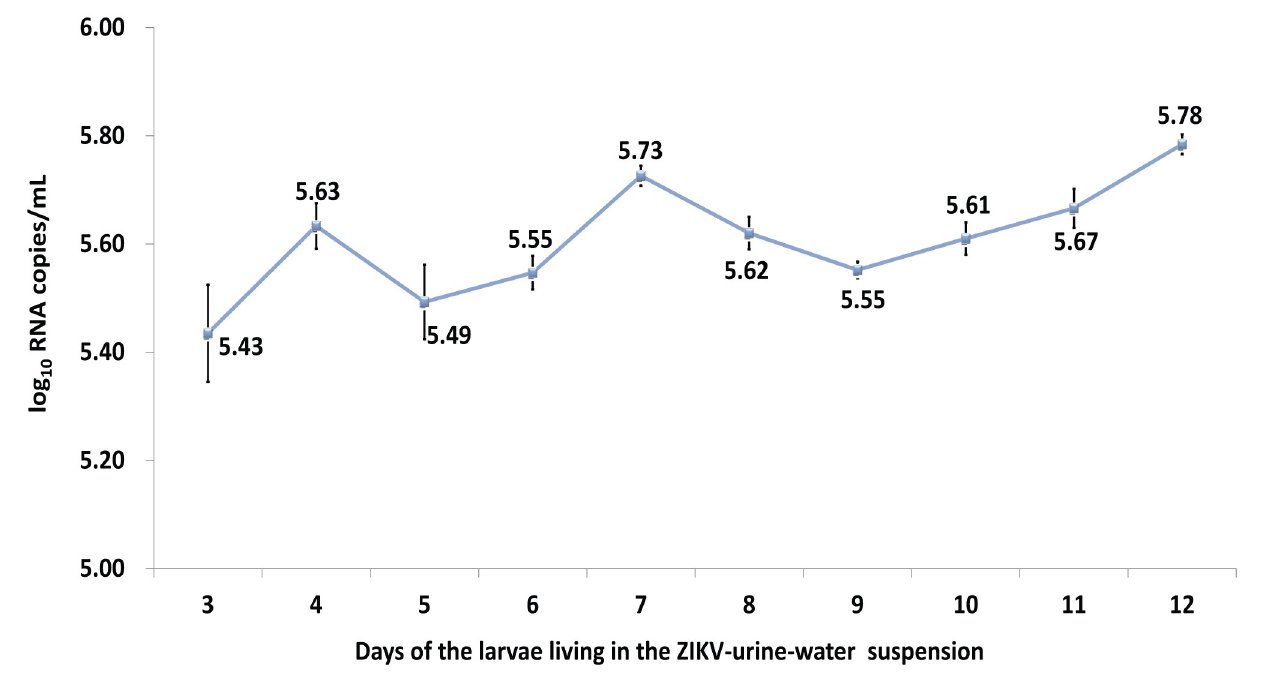
Fig 1. Quantification of Zika viral RNA copies detected in the ZIKV-urine-water suspension that larvae were reared. (There was no significant difference in the viral RNA titers in the continuous sampling on day 3–12; however, no infectious virus was detected on any of the sampling days).